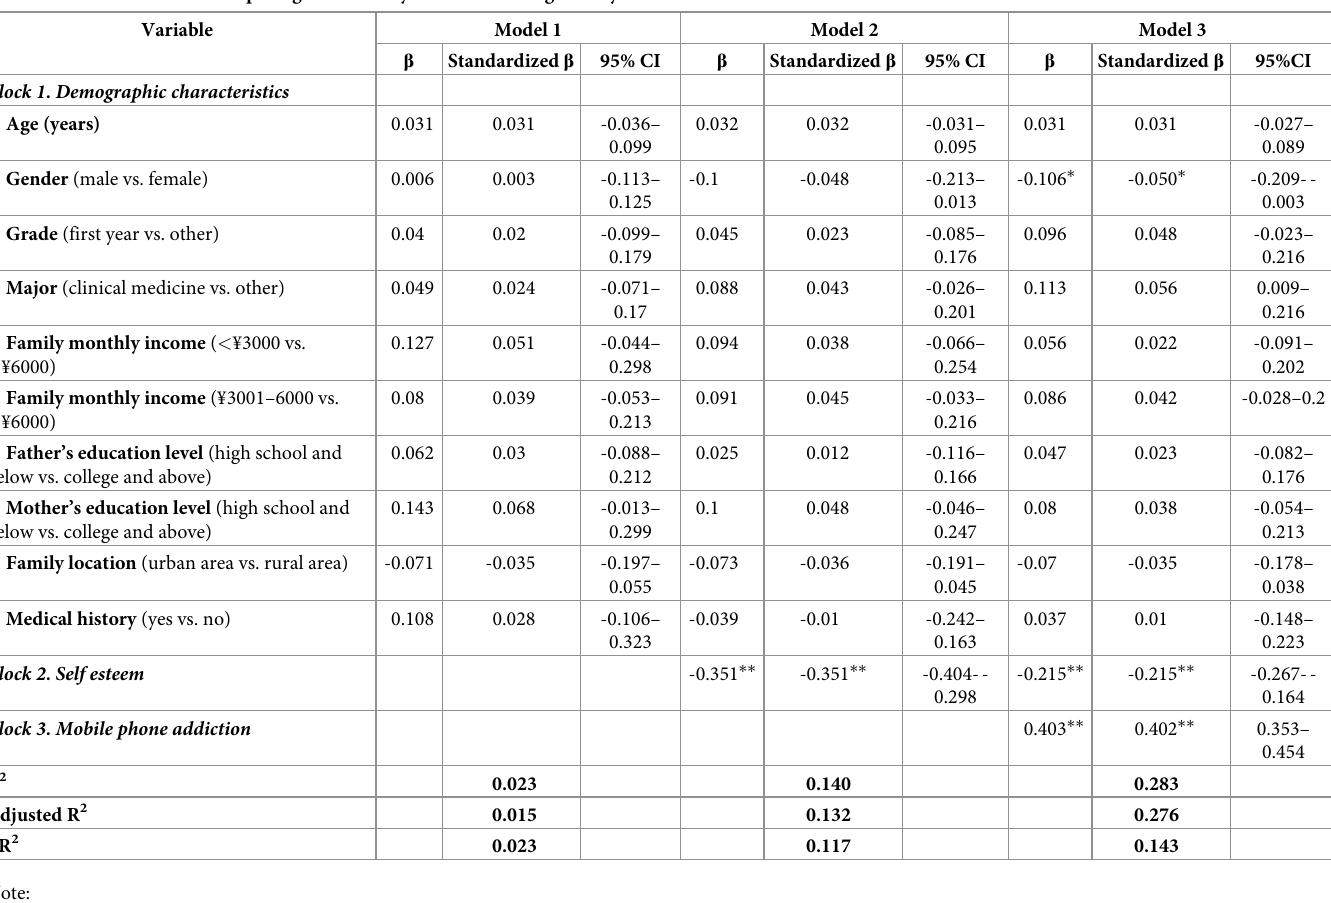
Table 3. The hierarchical multiple regression analysis of EFL writing anxiety.